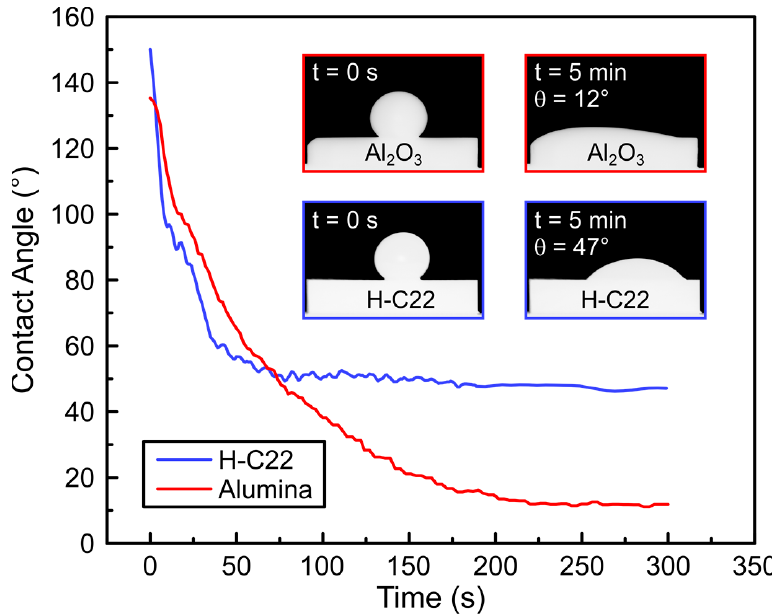
Figure 3. Values of the contact angle of BTi-5 on Hastelloy C22 ® (blue line) and Al 2 O 3 (gray line) planar substrates with respect to the time of the thermal treatment carried out at 900 °C in a vacuum atmosphere of at least 5 × 10 − 4 Pa.